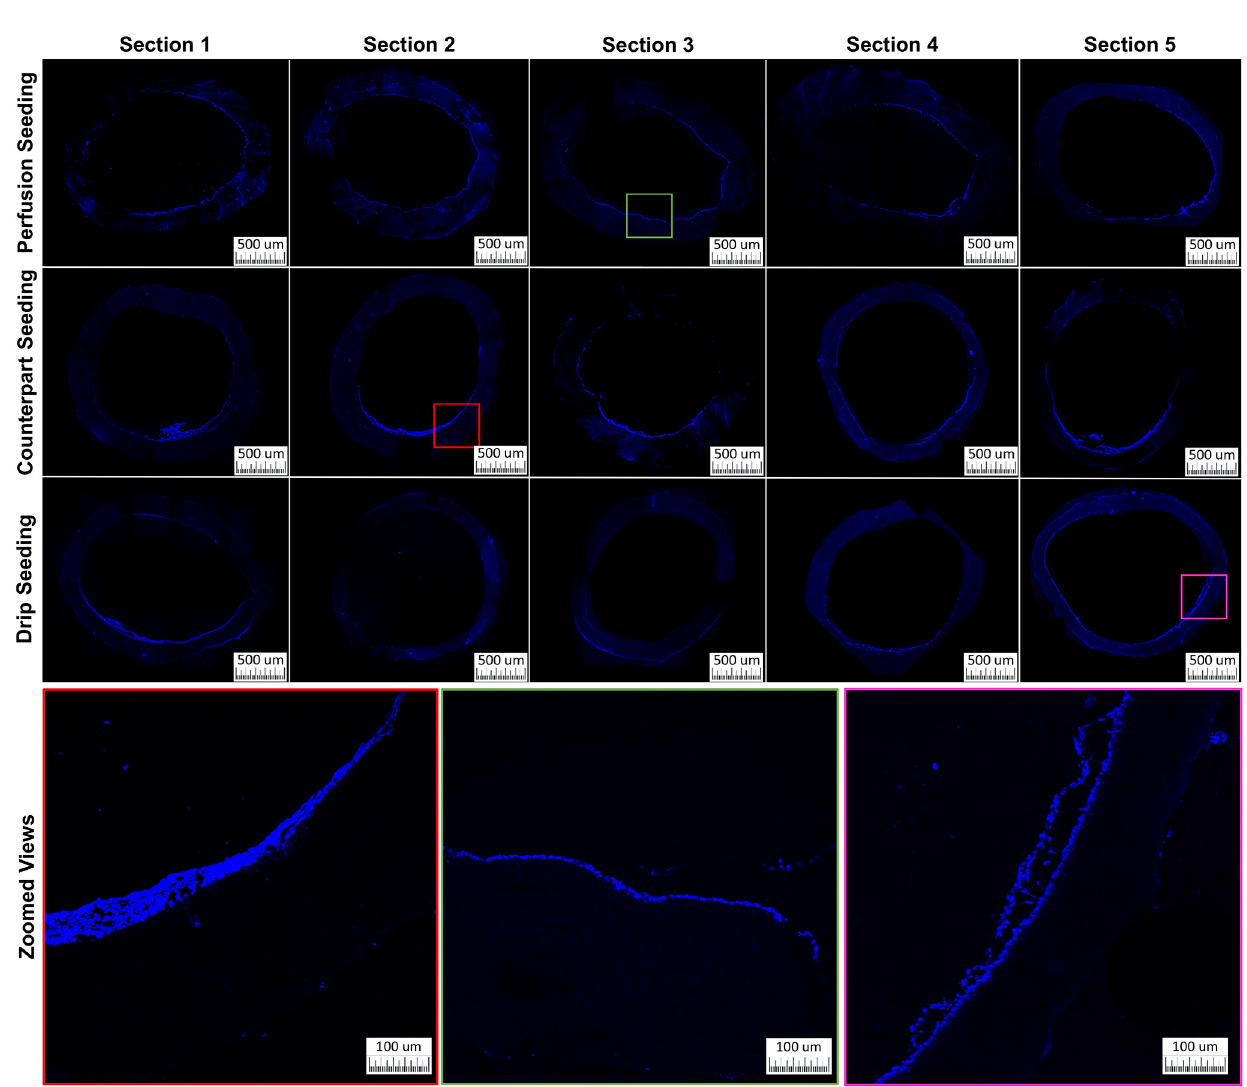
Fig 6. DAPI cross-sections. DAPI stained nuclei of cells in cross sections of each seeding method 24 hrs after seeding in longitudinal order.